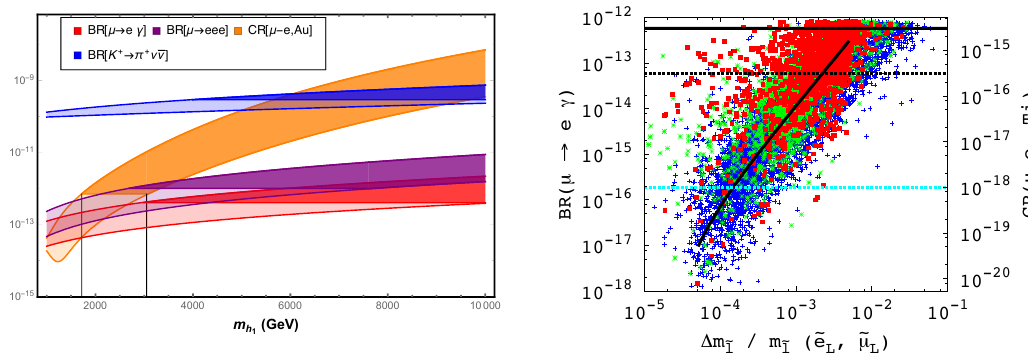
Figure 5: On the left, contributions to BR( µ → e γ ), BR( µ → 3 e ), CR( µ − e , Au) and BR( K + → π + ν ¯ ν ) as a function of the h leptoquark mass m , for h flavour h 1 1 1 couplings complying with the current intervals for R ; light (dark) surfaces denote K ( ∗ ) currently allowed (excluded) regimes due to the violation of the associated experi- mental bound (from [ 42 ] ). On the right panel, 1 st and 2 nd generation charged slep- ton mass splittings vs. BR( µ → e γ ), with CR( µ − e , Ti) on the secondary y-axis in a type I SUSY seesaw, for different values of the heaviest right-handed neutrino mass = 10 13,14,15 GeV ( M = 10 10,11 GeV) and for a flavour conserving modified M R 3 R 1 , R 2 mSUGRA benchmark (from [ 43 ]